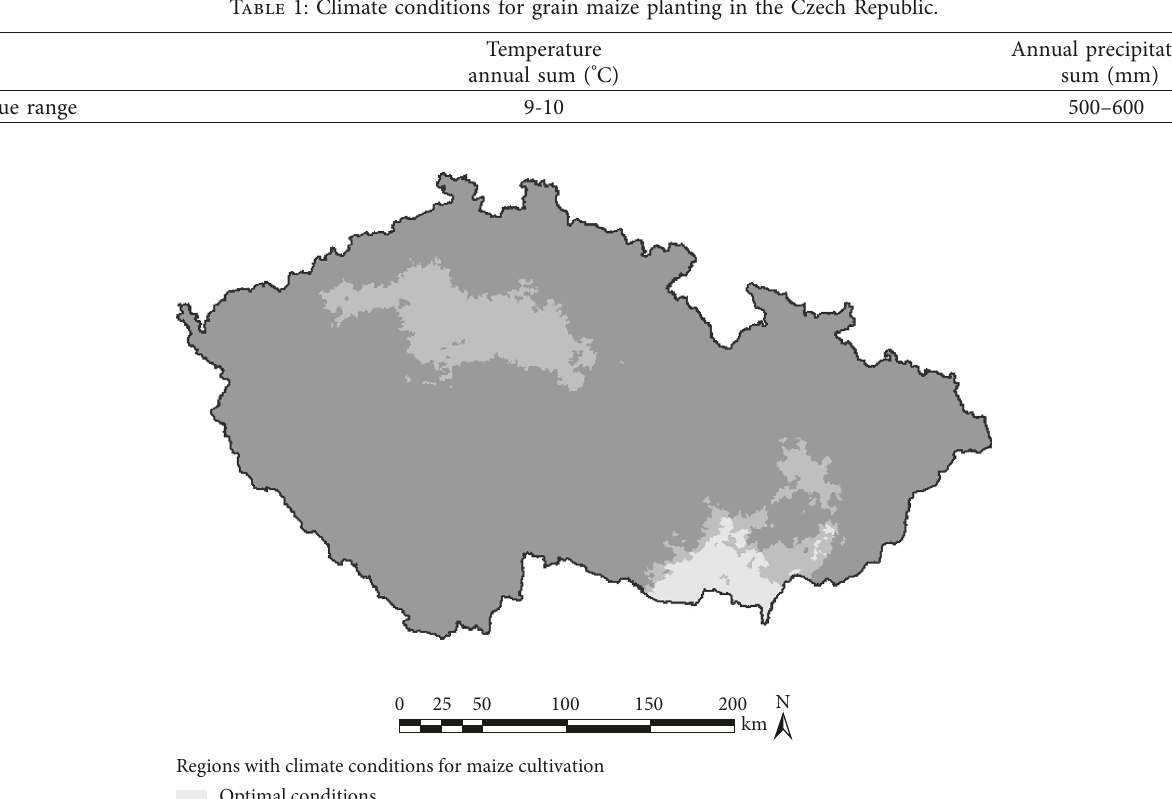
Figure 1: Scheme of biogeographical model processing.